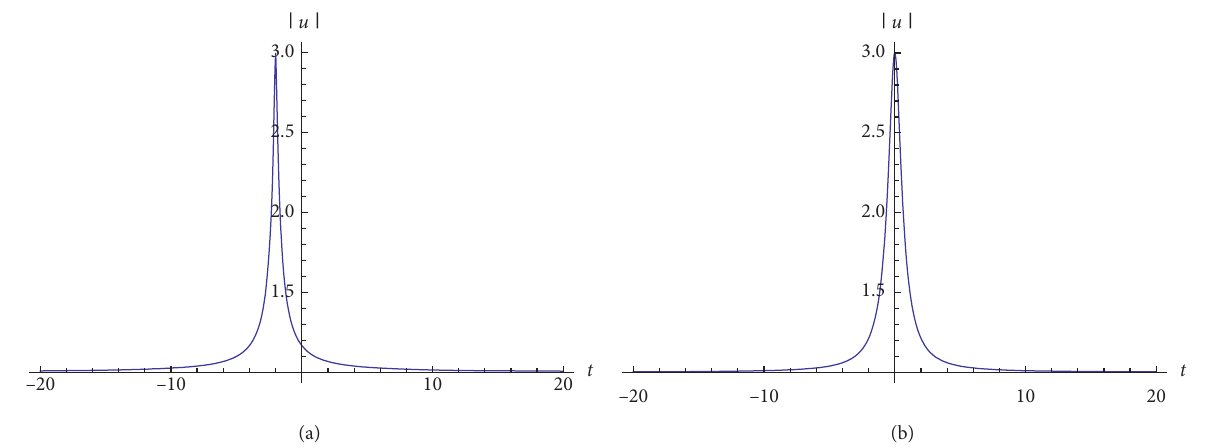
Figure 5: Dynamic evolution of first-order fractional rogue wave solution (33) and its comparison with the integer order. (a) α � 5/7, a � − 2, and x � − 2. (b) α � 1, a � 0, and x � 0.